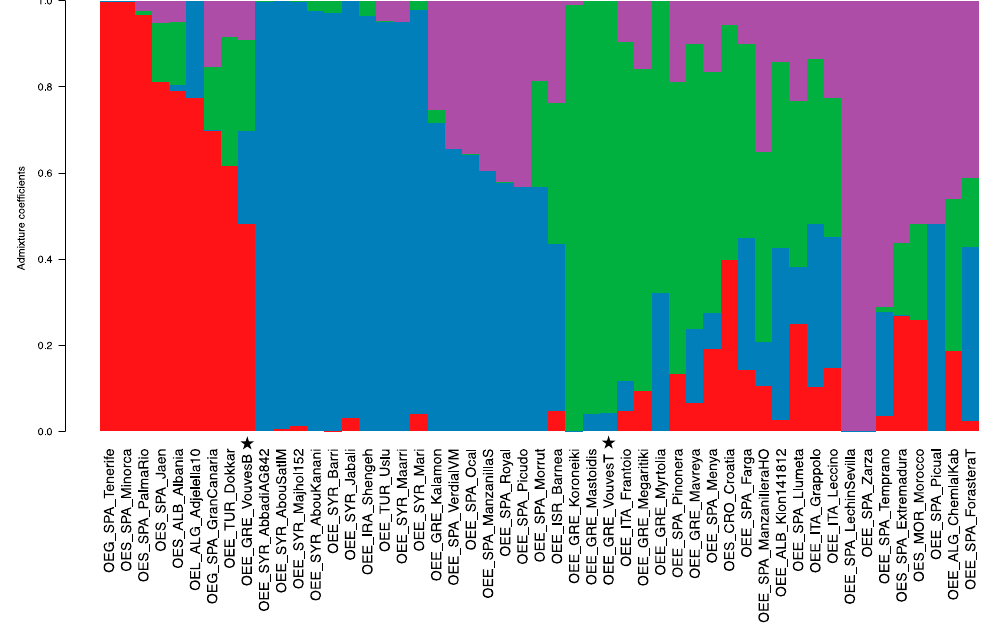
Figure 4. Admixture analysis for K = 4. Four populations are represented with the following colors: Red (noted in the text as G1) composed mostly by wild accessions ( Olea europaea subsp. laperrinei ; Olea europaea subsp. guanchica ; and Olea europaea var. sylvestris ); Purple (noted in the text as G2) has southern Spain accessions and some Olea europaea var. sylvestris ; Blue (noted in the main text as G3) is composed by individuals from Syria and Iran; Green (noted in the text as G4) present-day Greek and Italian accessions and some accessions from north-western Spain. Vouves tree samples have been marked with a